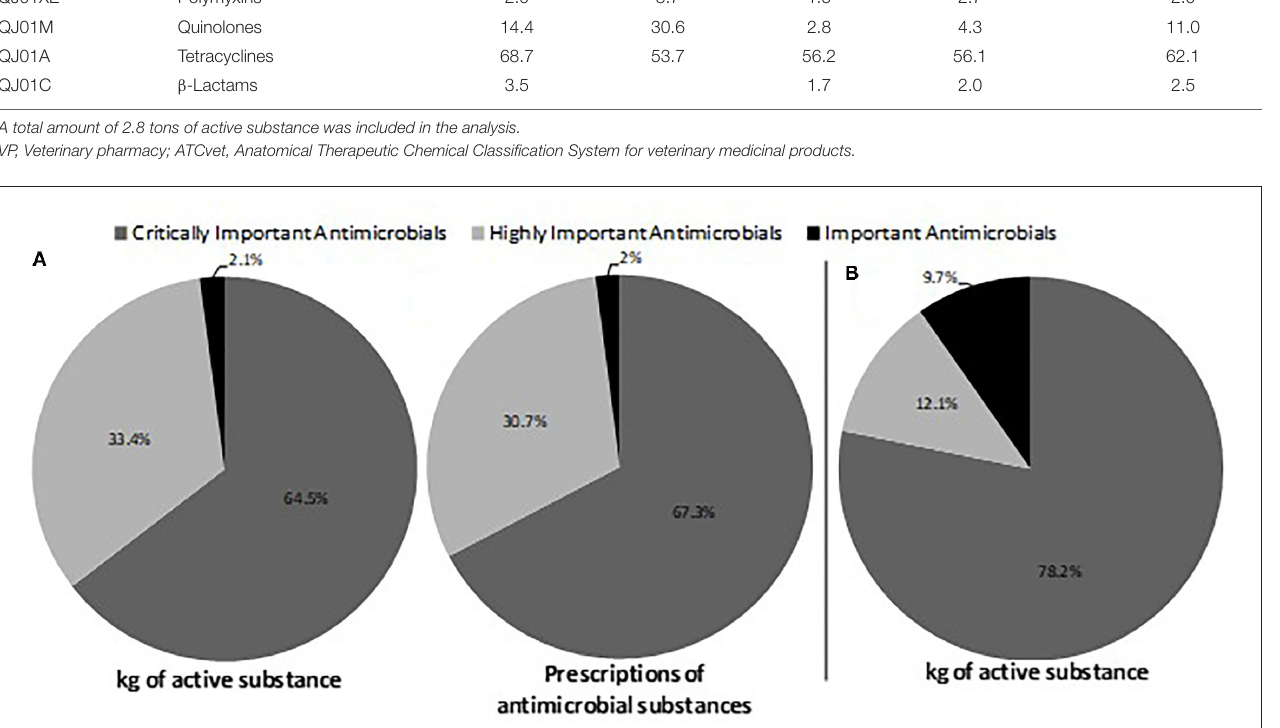
FIGURE 2 | Classification of the antimicrobials used according to the WHO categorization of antimicrobials according to their importance to human medicine. (A) Percentages of the amount of active substance in each category for four veterinary pharmacies in the West Region of Cameroon in 2011. (B) Percentages of the amount of active substance and percentages of prescriptions in each category for 50 layer poultry farms in the West Region in Cameroon from January 2012 to December 2012.